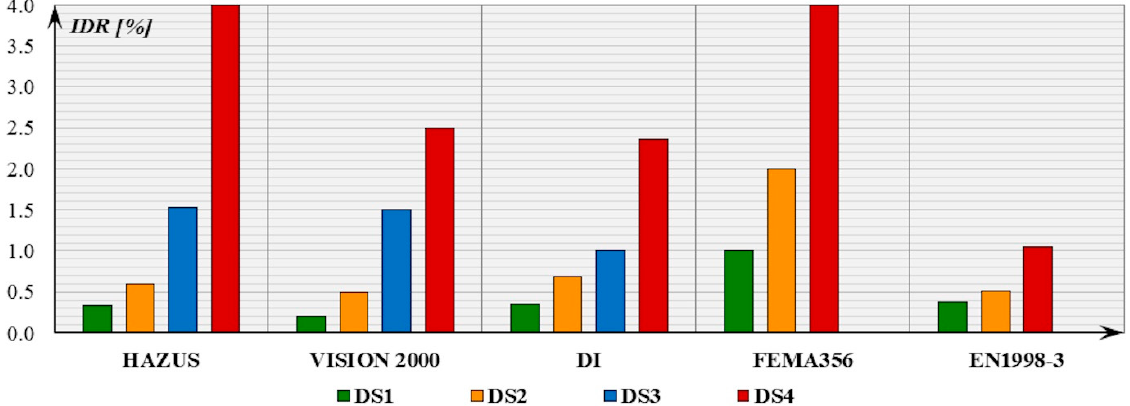
Figure 14. IDR values of particular DSs for each of the selected methods of damage assessment.